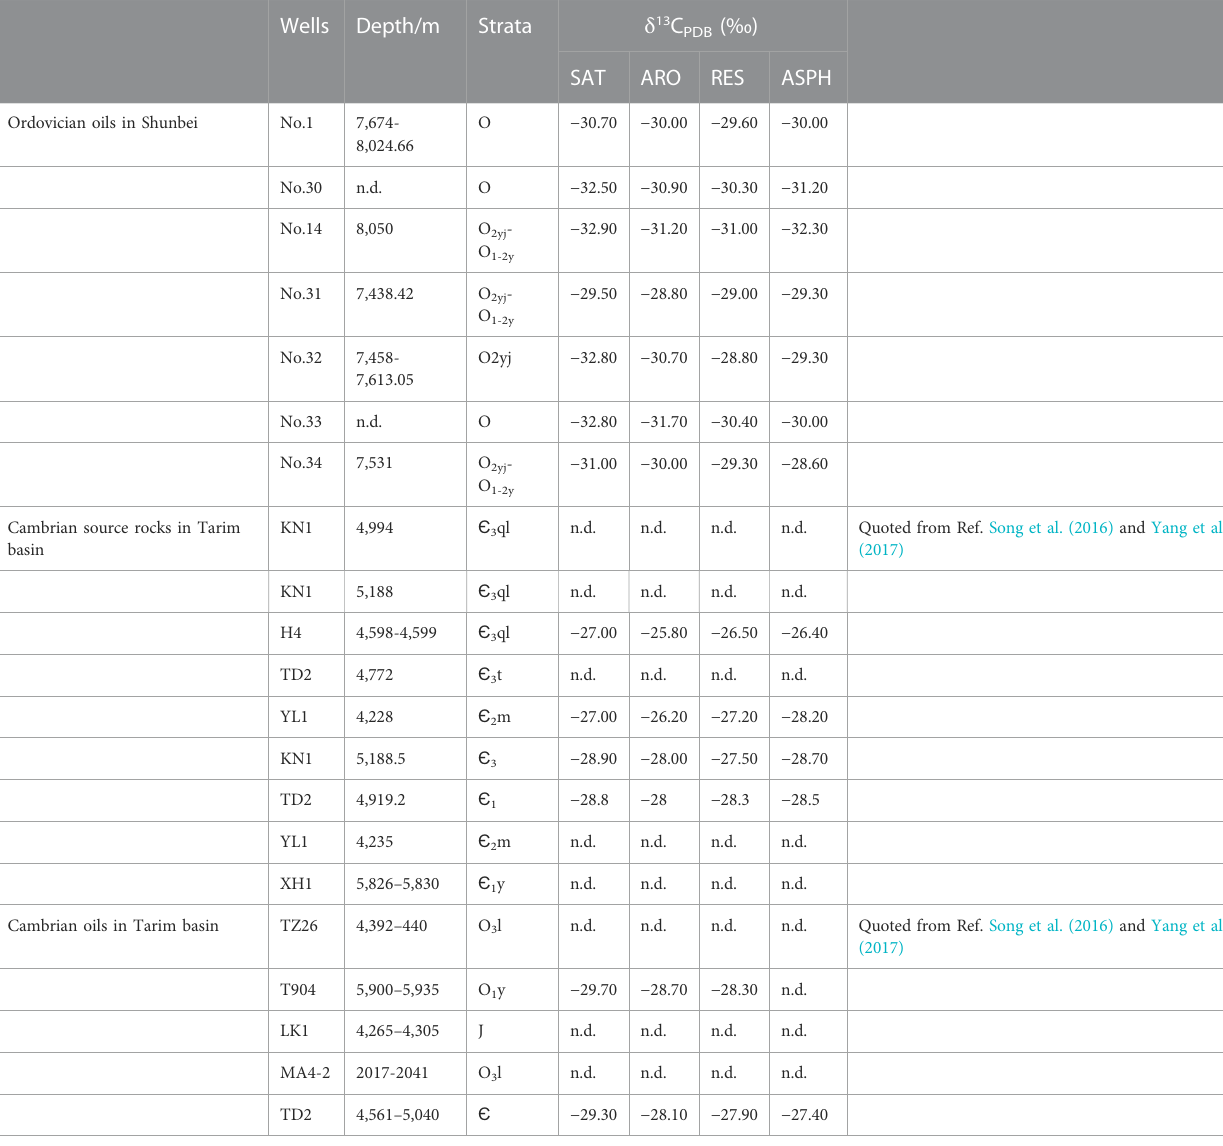
TABLE 2 Carbon isotope for Cambrian source rock extracts, typical Cambrian oils and typical Ordovician oils from the Tarim